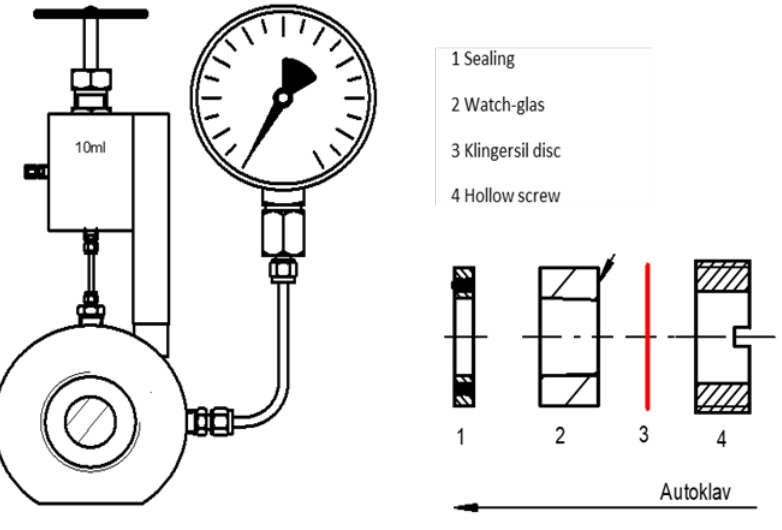
Figure 3. Schematics of the used 10 mL window